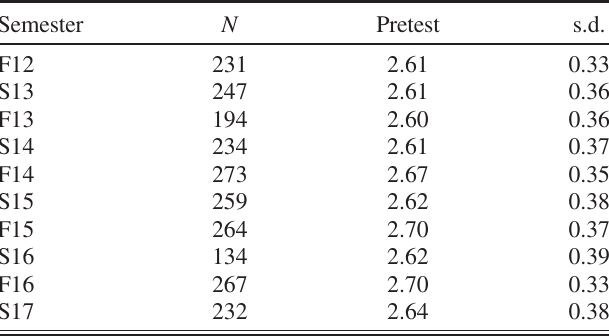
TABLE XII. Pretest mean across all study semesters on EBAPS overall axis. a